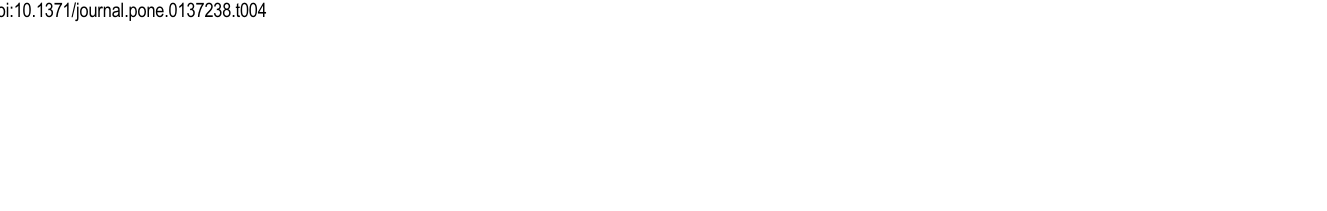
Table Notes: Q1 = N players born between Sept-Nov of annual age cut-off dates, Q4 = June-August; ES = effect size; MVJ = maximal vertical jump; MSFT = multi-stage fi tness